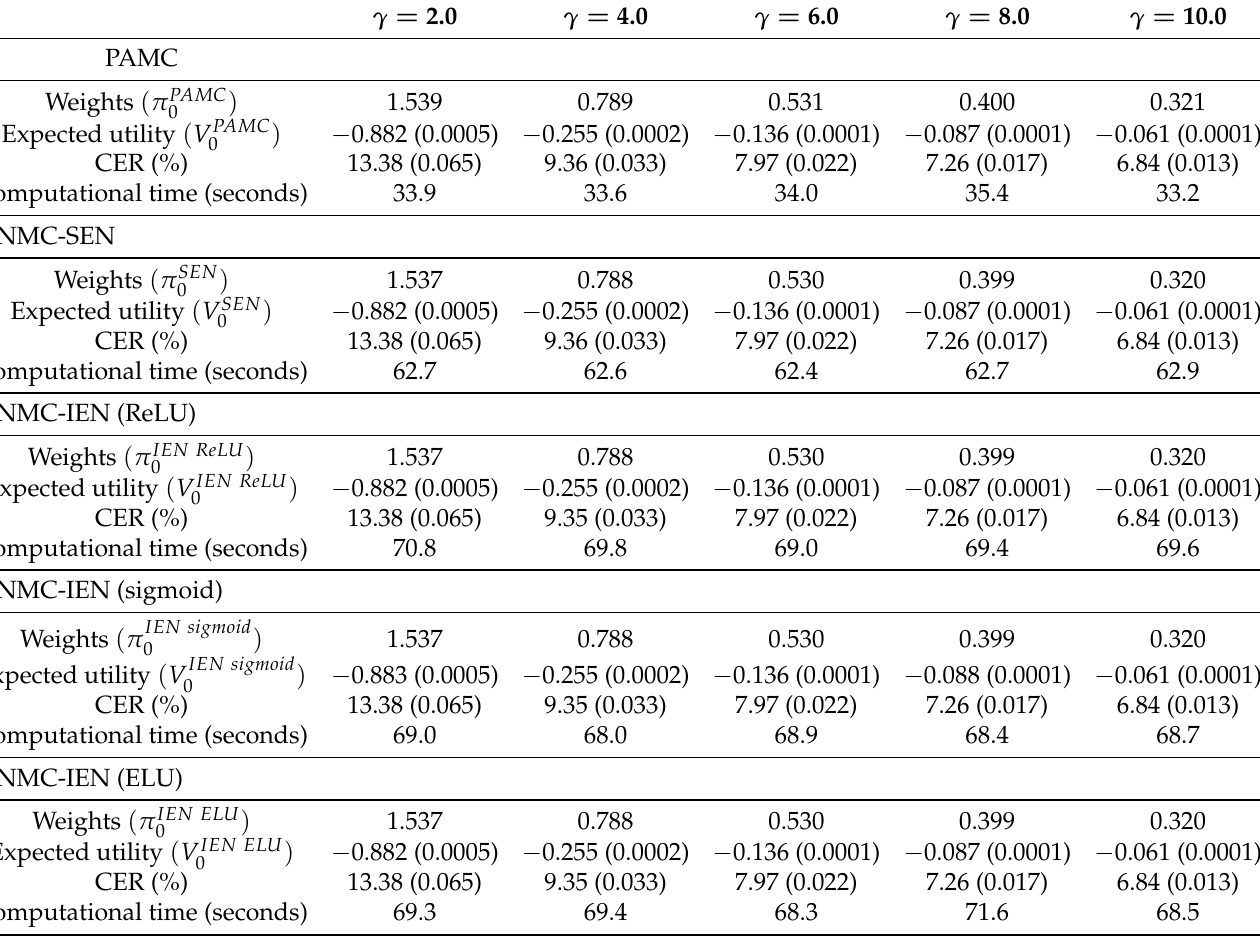
√ ) . We report the estimation of optimal X t + b S √ Table 5. Results for the 4/2 model with a market price of risk λ S ( a S X t weights, expected utility and CER obtained via approximations given different levels of risk aversion γ . The standard deviation of estimated expected utility and CER from 100 runs is displayed in parentheses. γ = 2.0 γ =